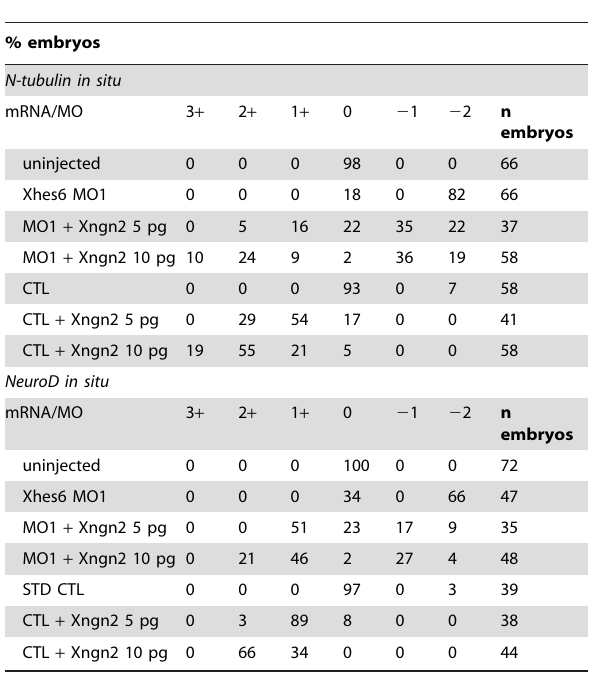
Table 2. Activity of Xngn2 in Xhes6 morphant embryos.